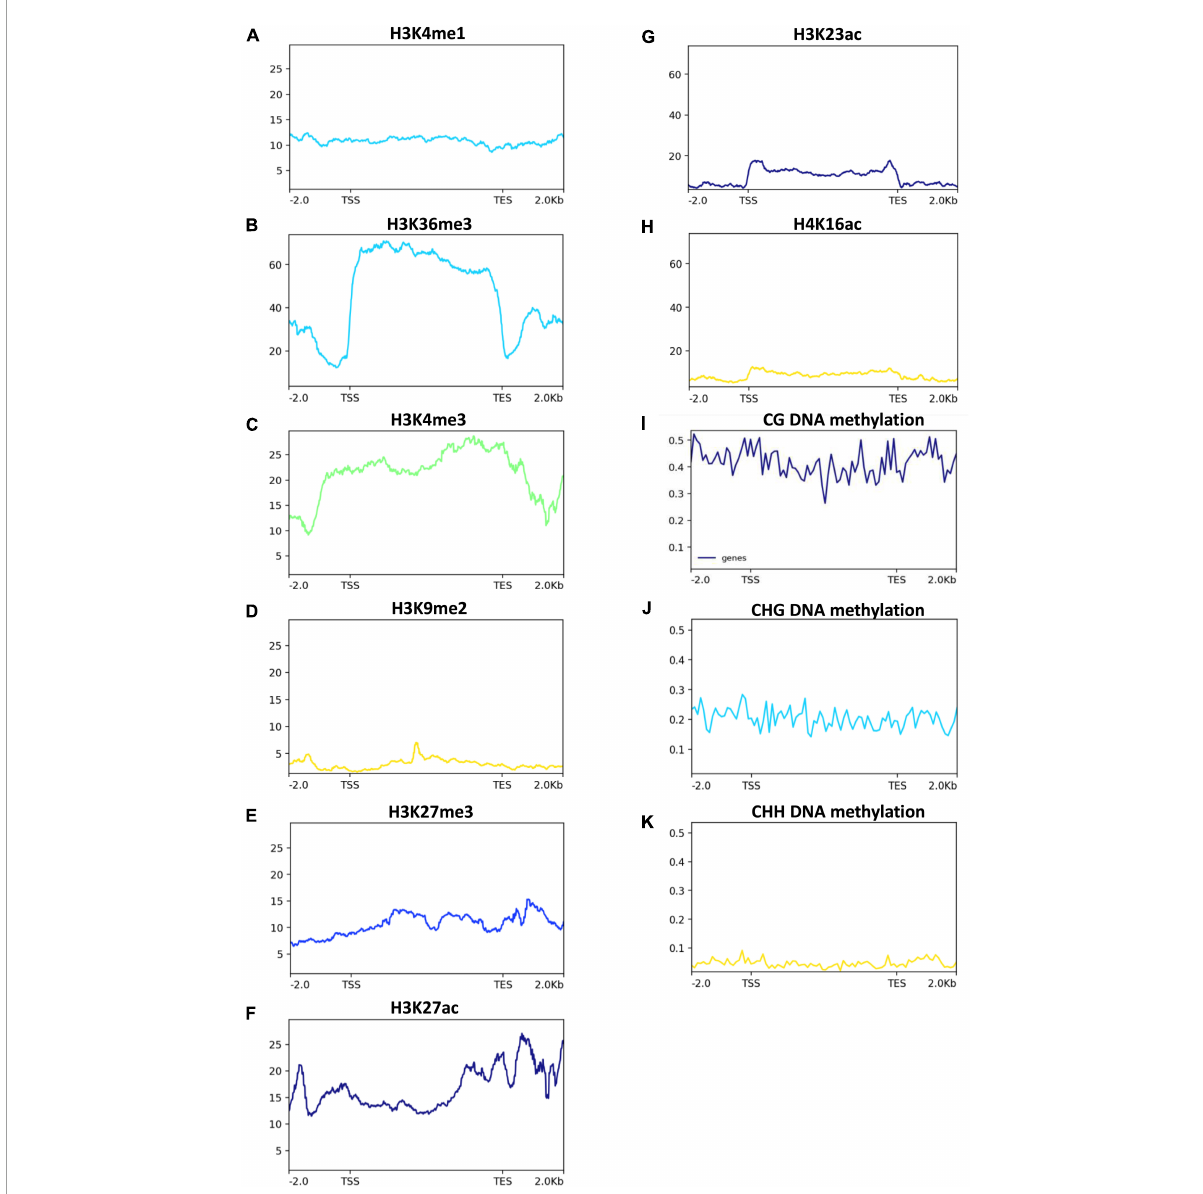
FIGURE8 Histone acetylation and DNA methylation status in 2-AP biosynthesis pathway-related genes in rice. Published data were used to plot histone acetylation and DNA methylation status. H3K4me1, H3K36me, and H3K4me3 (A–C) , are generally associated with transcriptional activation. While H3K27me3 and H3K9me2 (D,E) are generally associated with transcriptional repression. H3K27ac, H3K23ac and H4K16ac (F–H) , are generally associated with transcriptional activation. While DNA methylation (I–K) are generally associated with transcriptional